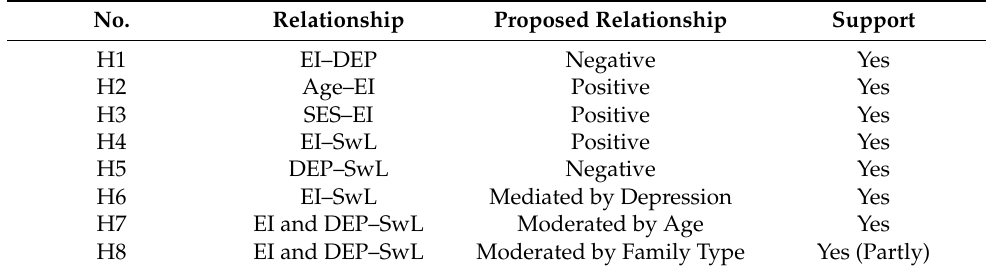
Table 6. Summary of hypotheses testing